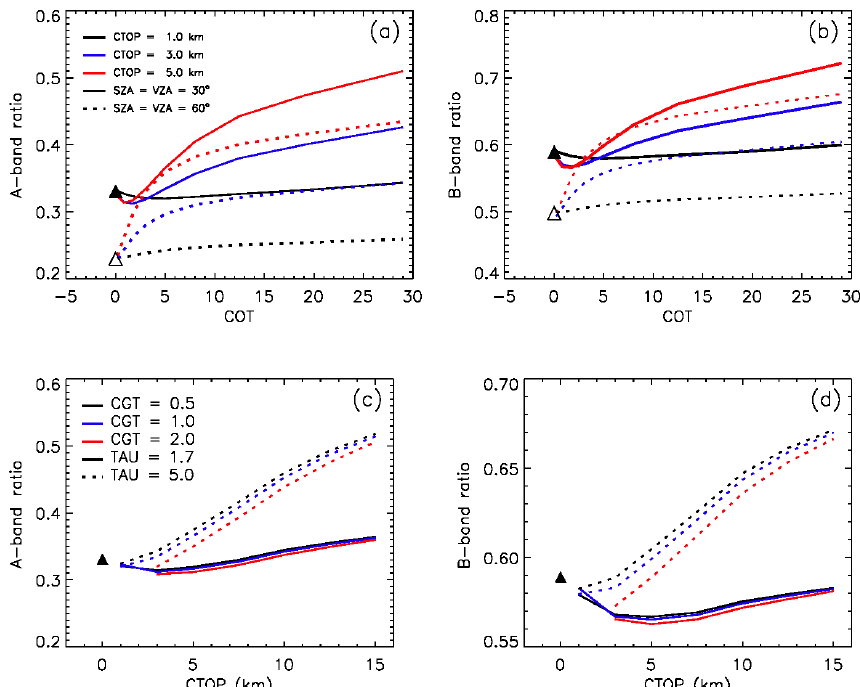
Figure 3. Model-simulated oxygen band ratios as a function of cloud optical thickness (COT) with cloud top height (CTOP) at 1.0km (black), 3.0km (blue) and 5.0km (red) and solar zenith angles at 30 ◦ (solid line) and 60 ◦ (dotted lines), respectively for the (a) A band and (b) B band. Cloud geometric thickness is 1km. Oxygen band ratios at solar zenith angle 30 ◦ as a function of CTOP with CGT of 0.5km (black), 1.0km (blue), and 2.0km (red) as well as COT of 1.7 (solid) and 5.0 (dotted line) for the (c) A band and (d) B band, respectively. View zenith angle is the same as the solar zenith angle and relative azimuth angle is 160 ◦ for all the simulations. The clear-sky simulations are marked with filled and unfilled triangles for solar and view zenith angles at 30 and 60 ◦ , respectively. Both clear-sky and cloudy-sky simulations use standard US atmosphere and zero ground elevation. Surface albedo is set at 0.8 to represent snow and ice